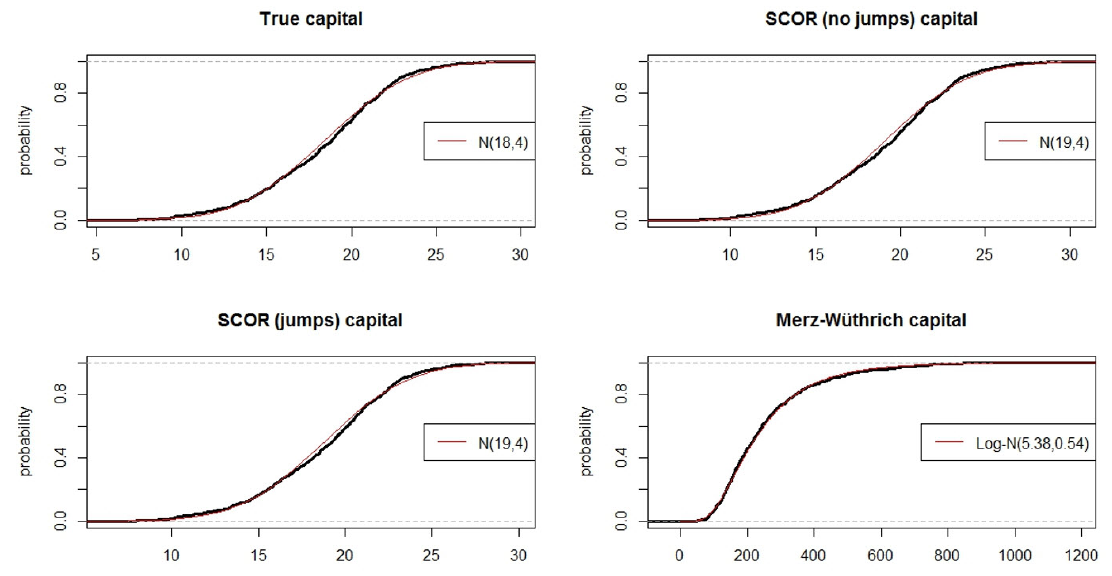
Figure 3. Simulated distribution of the capital for the different